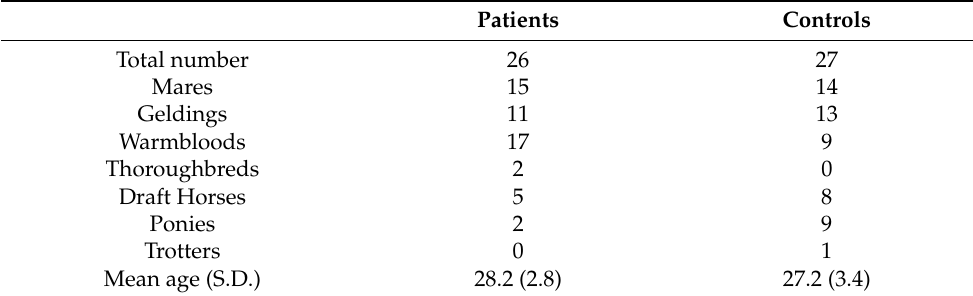
Table 1. Data of the horses that were included in the study ( n = 53).